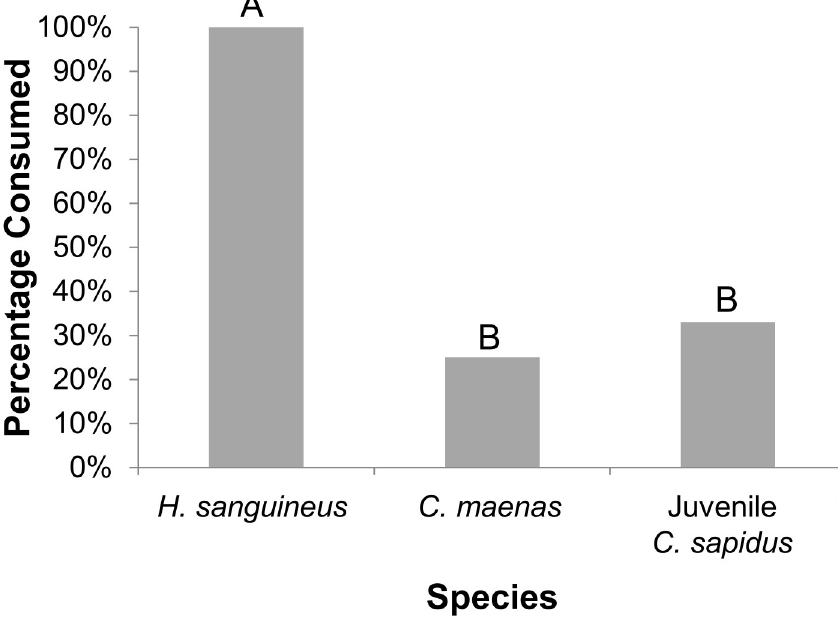
Fig 4. Natural predation in the field on H . sanguineus compared to C . maenas and C . sapidus : Percentage of consumed H . sanguineus , C . maenas , and C . sapidus over a 24 hour period. Different letters indicate significant differences between treatments at α =